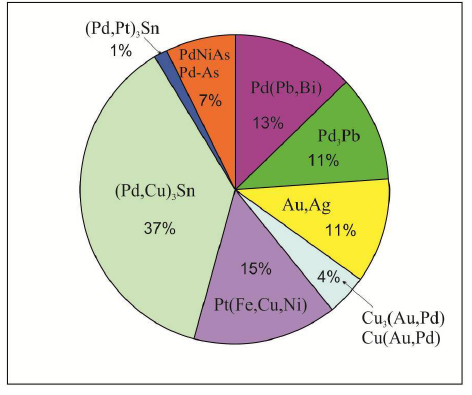
Figure 11. Relationships of the PGE minerals in ores of the Southern 2 orebody. It differs from the mineral previously described in the literature by the excess of Cu in the composition of most of the grains, the amount of which above the one unit is added to Pd in the mineral formula: (Pd,Cu) 5 Sn 2 Cu. Rustenburgite and atokite are found in intergrowth together with a clear phase boundary between them (Figure 12a), although both these minerals form an extended series of solid solutions. Both these minerals contain Cu and Ni (Table 6). Table 6. Mineral compositions in the system Pd-Pt-Cu-Sn from the Southern 2 orebody, wt %. No. Ni Cu Pt Pd Sn